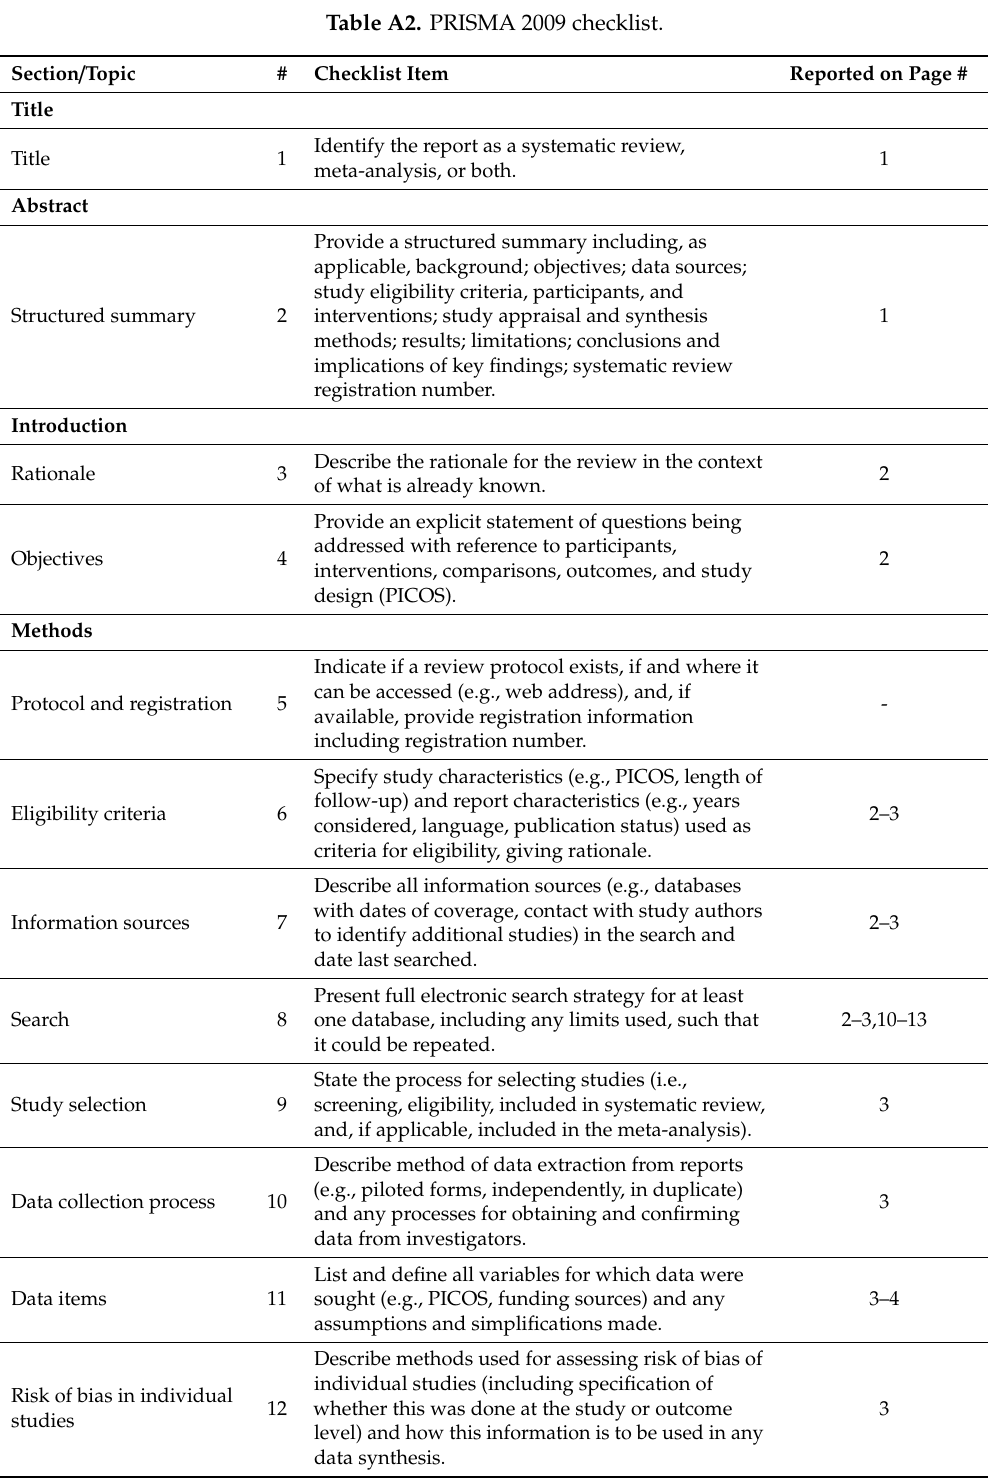
Table A2. PRISMA 2009